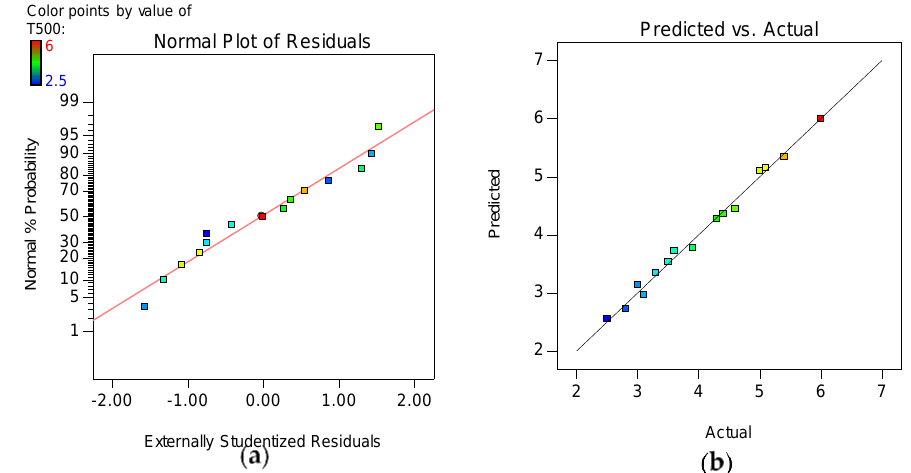
Figure 12. ( a ) Normal plot of residuals and ( b ) Actual vs. Predicted plot for T 500.